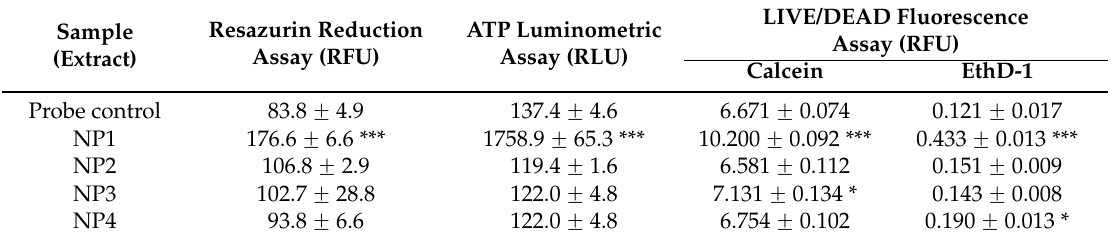
Table 2. Optical readouts caused by birch (NP1), milk thistle (NP2), olive (NP3), and propolis (NP4) extracts using three cell viability assays, in the absence of cells. Values are shown as mean ˘ SD ( n =